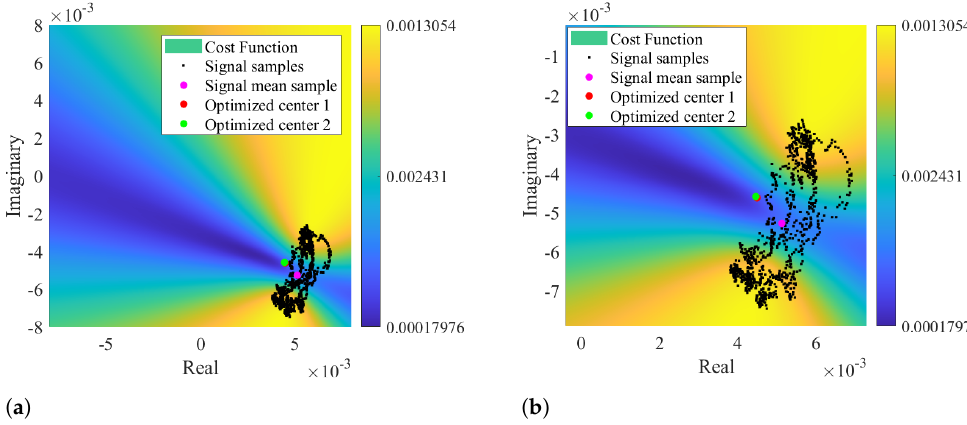
Figure 7. Color map of the cost function result using signal mean value as optimization starting point: ( a ) Representation of the optimized solution, ( b ) Zoomed visualization of the optimized